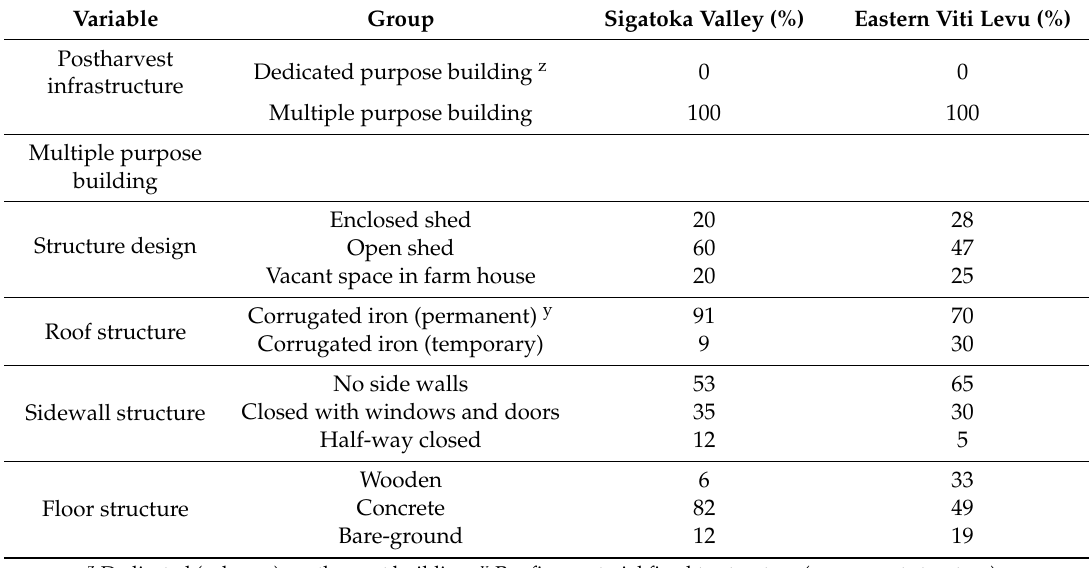
Table 3. Percentage (n = 108) of Fijian tomato farmers who have on-farm postharvest infrastructure. Variable Group Sigatoka Valley (%) Eastern Viti Levu (%) Postharvest